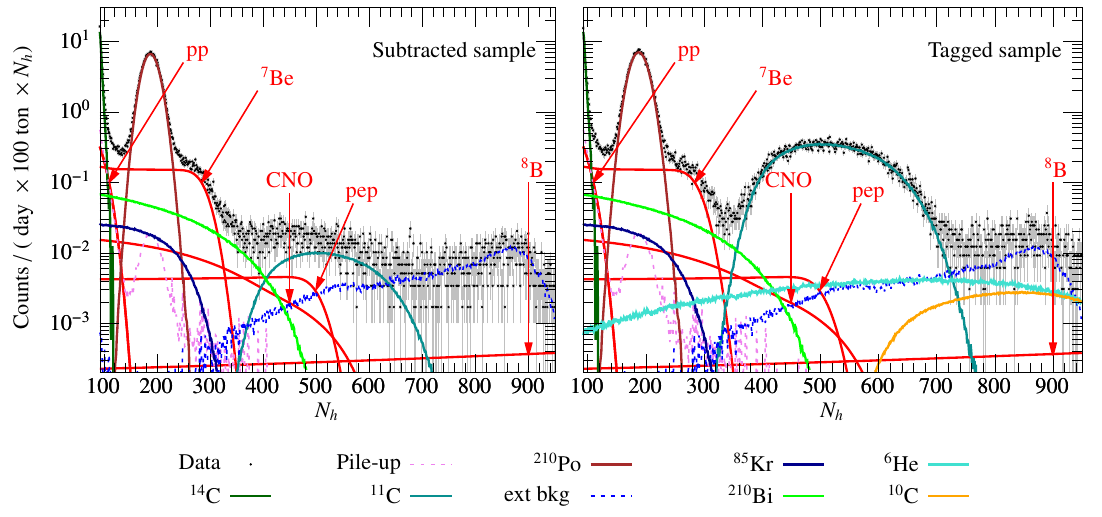
Figure 8 . Spectrum for the best-fit normalizations of the different components obtained from our fit to the Borexino Phase II data for TFC-subtracted (left) and TFC-tagged events.